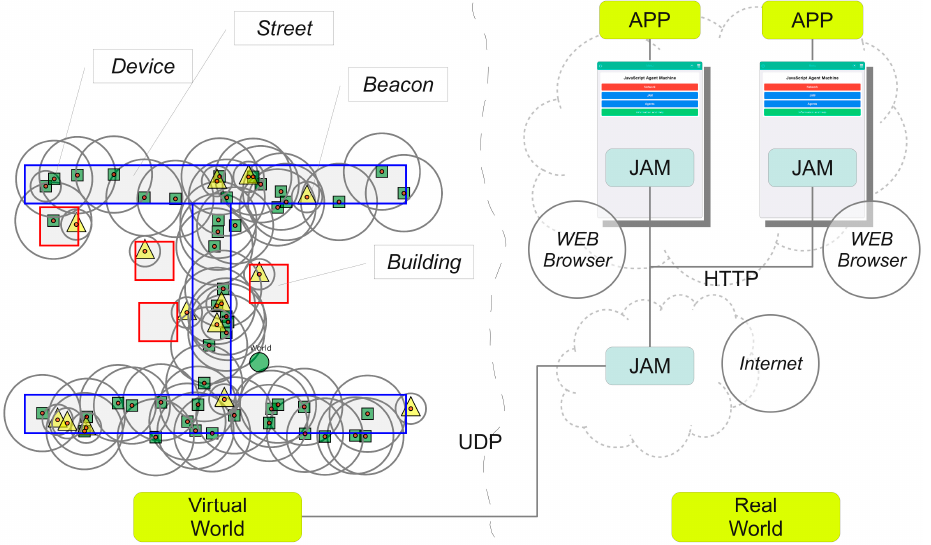
Figure 12. A demonstrator: An artificial street area consisting of street segments (blue rectangle), buildings (red rectangles), and beacons (yellow triangles), populated with stationary and mobile devices (green squares). The grey circles around beacons and nodes show the wireless communication range. Only overlapping circles connect .